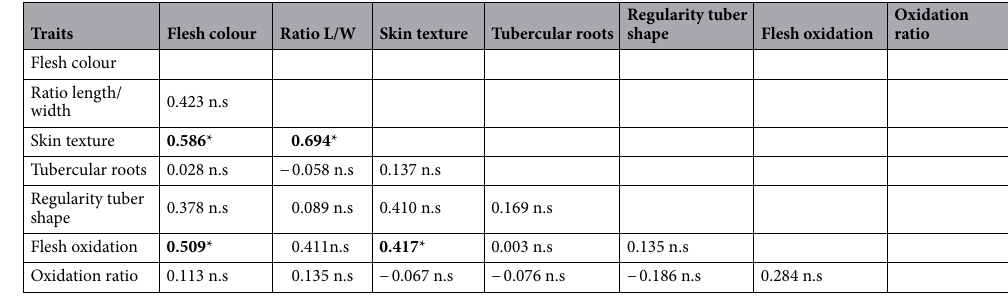
Table 3. Correlation coefficients (Spearman’s r values) computed mean values over years between ratio length/ width, regularity of tuber shape, skin texture, tubercular roots, flesh colour, flesh oxidation, oxidation ratio of mapping population A (74F × Kabusa). Significant values are in [bold]. n.s: not significant. *Significant at p <